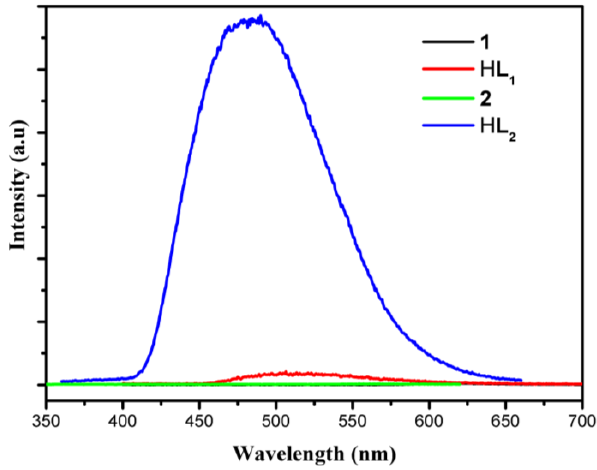
Figure 10. Emission spectra of H L 1 , H L 2 , 1 , and 2 in DMF solution (1.5 mM).